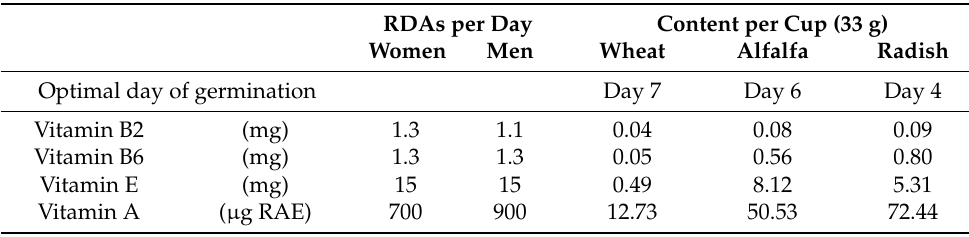
Table 2. Vitamins content of a cup of sprouts, taken at their optimum day of germination, compared to RDAs for women and men between 18 and 50 years